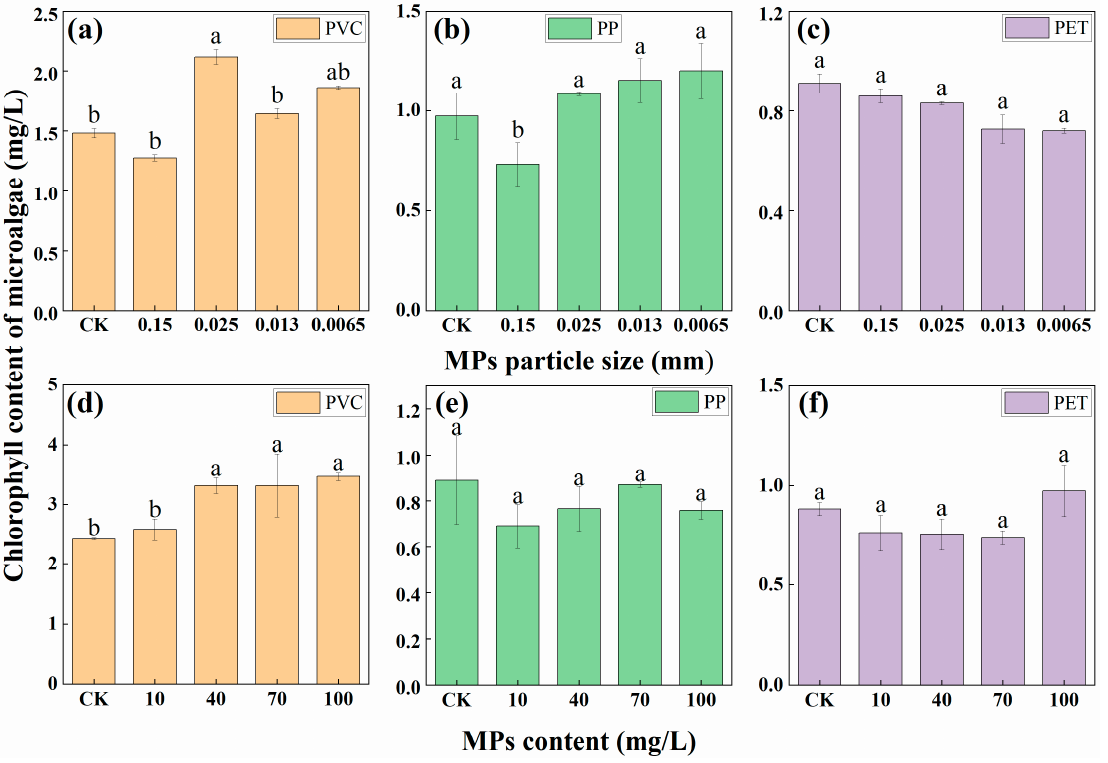
Figure 1. Chlorophyll content of microalgae treated by MPs with different particle sizes ( a – c ) and contents ( d – f ). Different letters above the error bars indicate statistically significant differences ( p < 0.05).